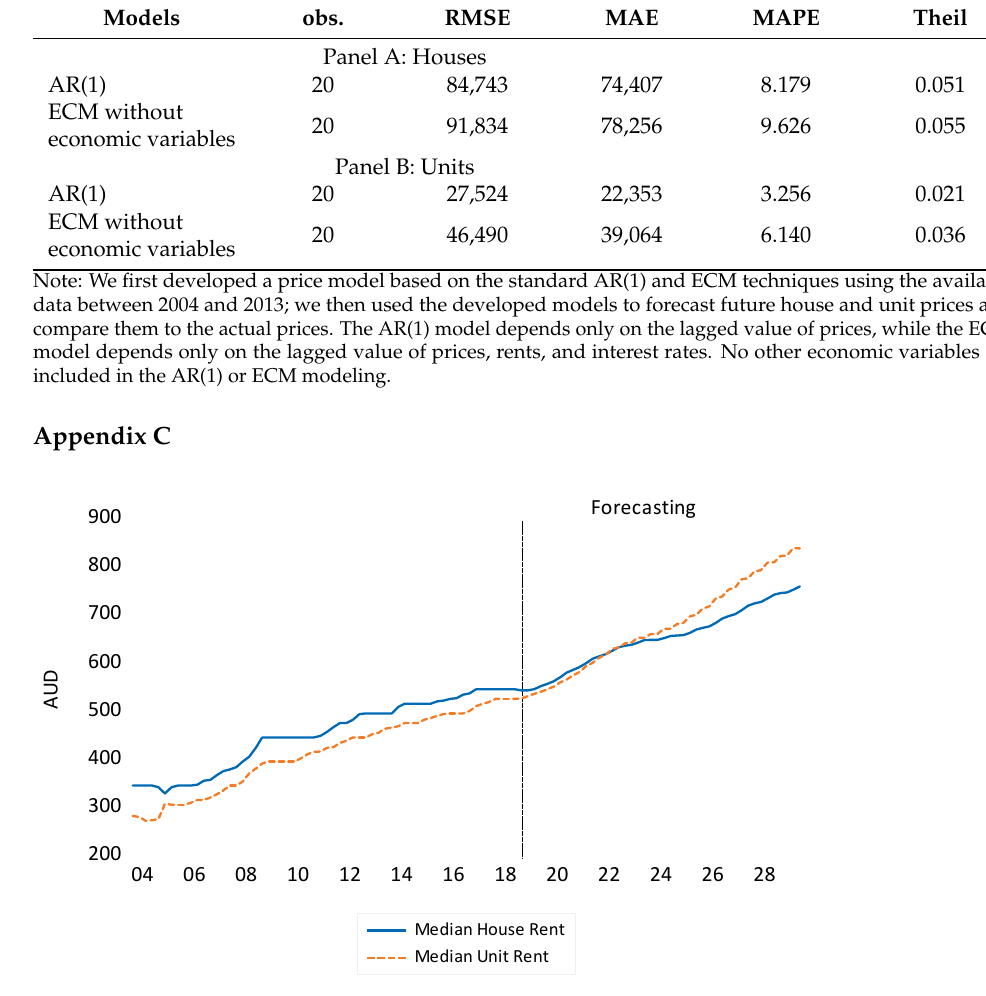
Figure A1. Forecasted Median Rents.